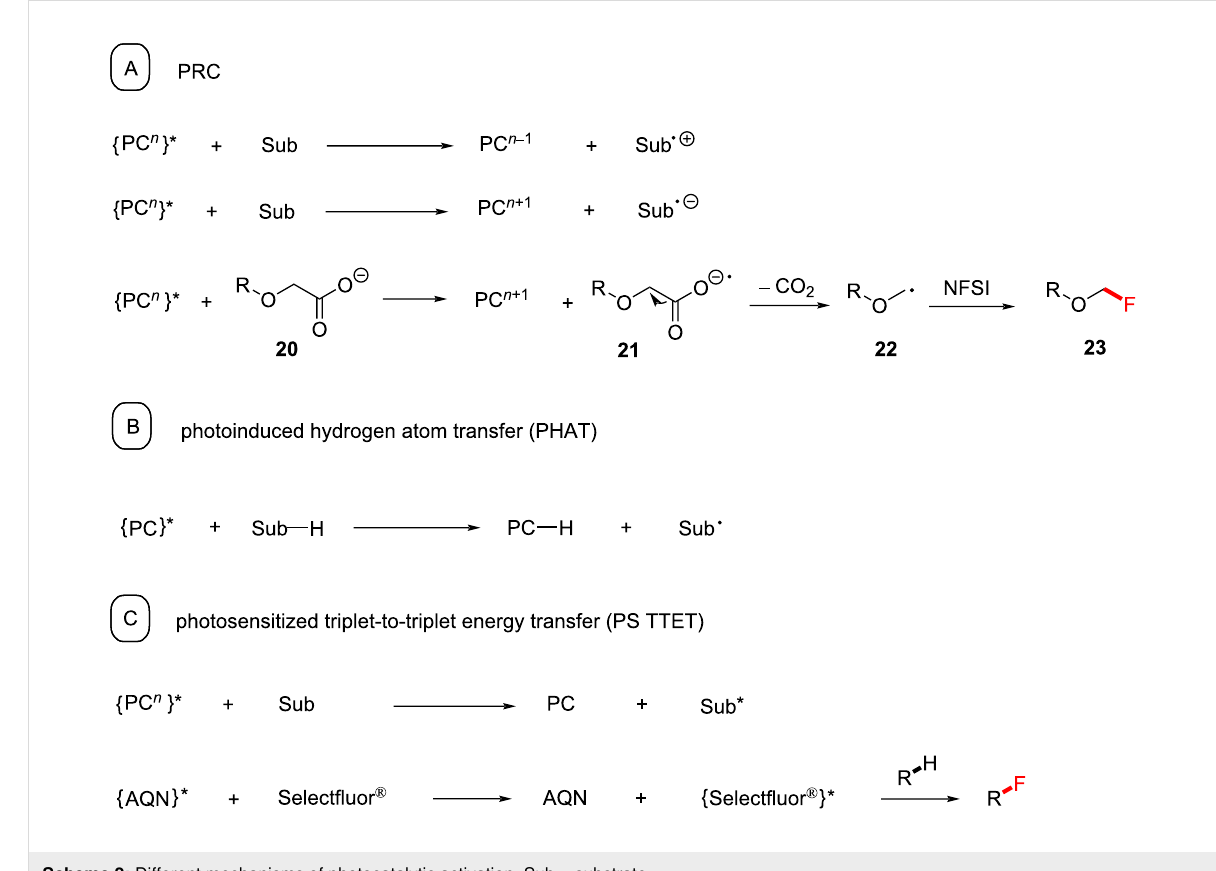
Scheme 2: Different mechanisms of photocatalytic activation. Sub = substrate.